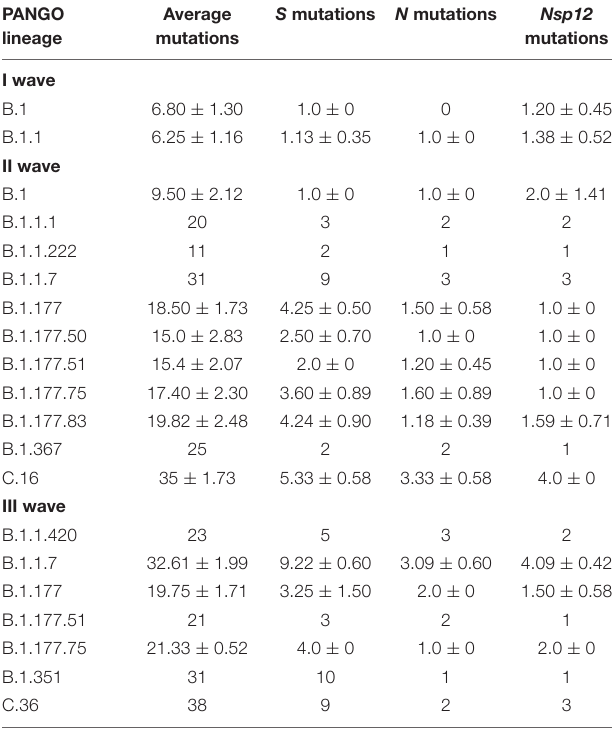
TABLE 3 | Average mutations per